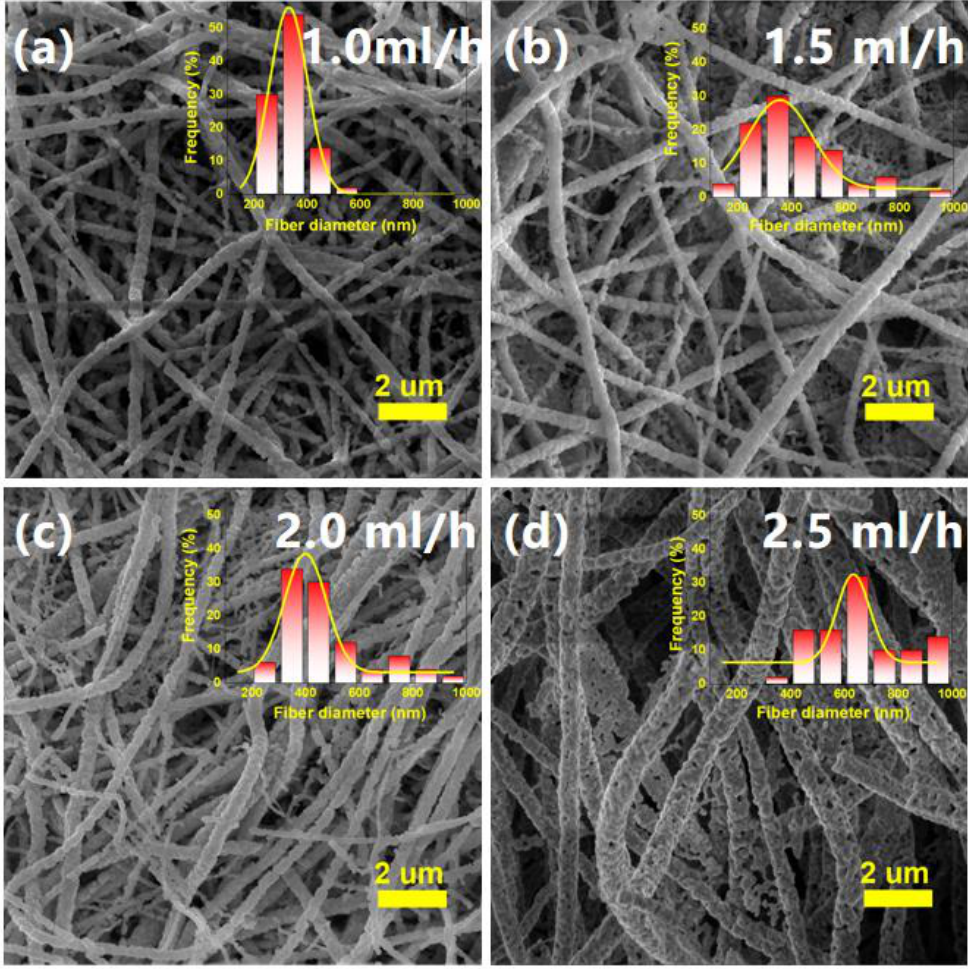
Figure 2. SEM images of NBT nanofibers obtained under different solution flow rates at the applied voltage of 20 kV and collection’s rotation speed of 1500 rpm: ( a ) 1.0 mL/h; ( b ) 1.5 mL/h; ( c ) 2.0 mL/h; ( d ) 2.5 mL/h. The inserted figures are the diameter distributions of NBT nanofibers.